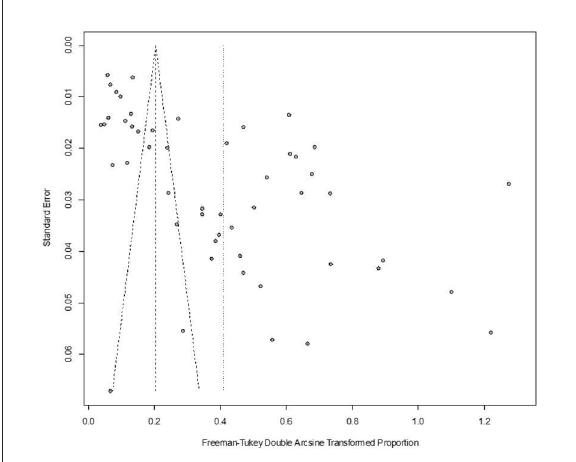
FIGURE4 Funnel plot with pseudo 95% confidence interval limits for the examination of publication bias (decetion